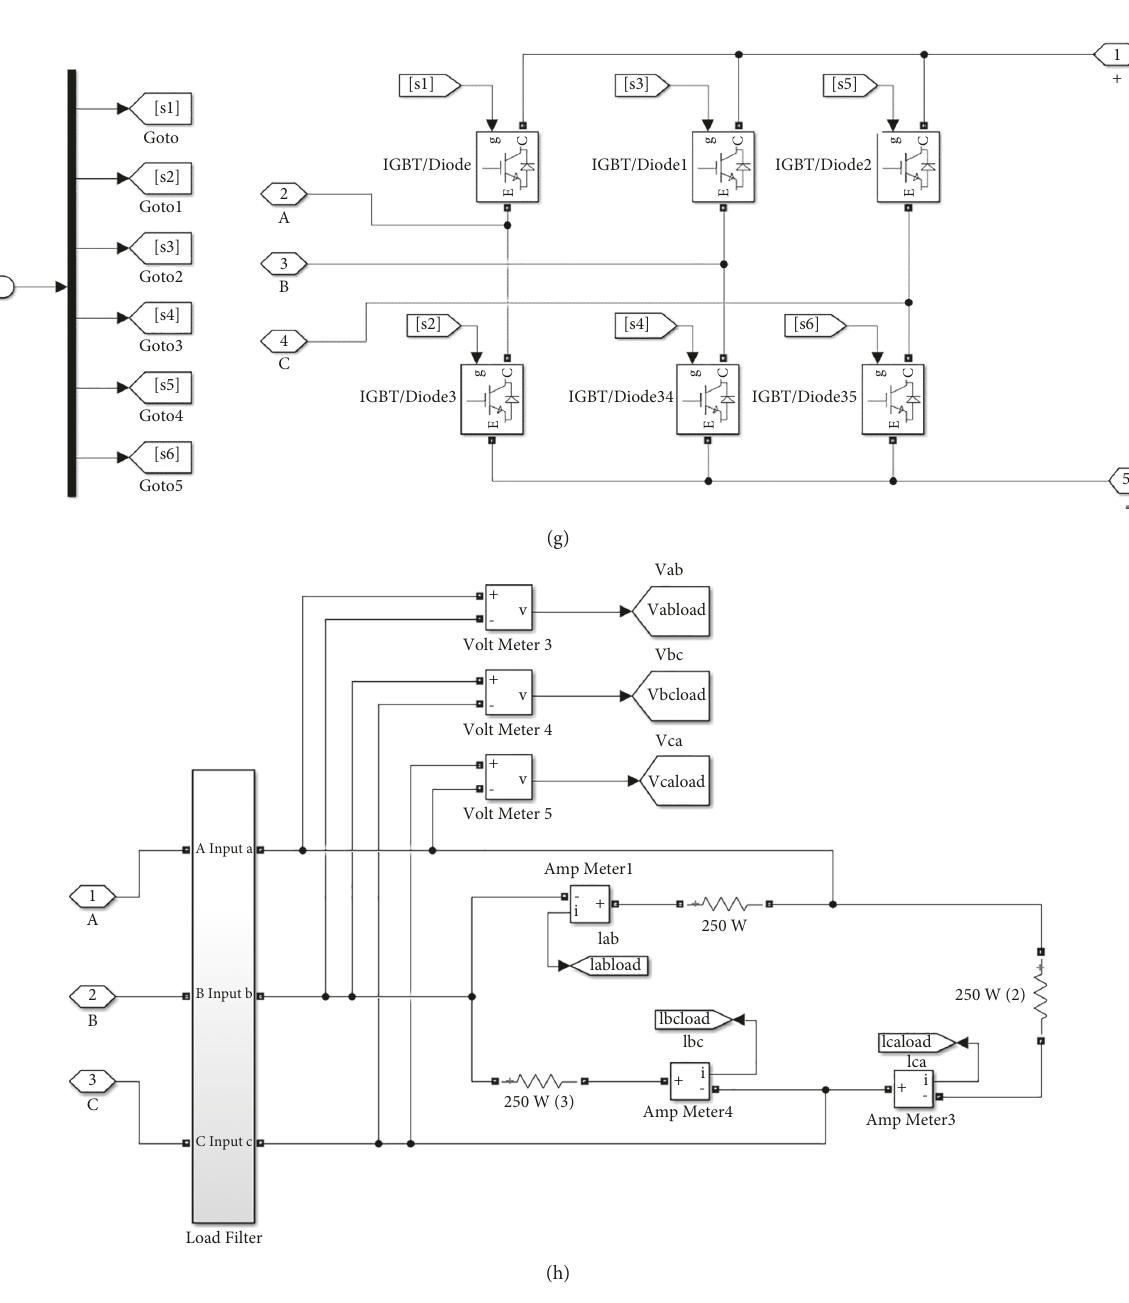
Figure 7: Model of the HVDC transmission line based on the experimental setup. (a) One-line diagram, (b) simulation model, (c) diagram and setup of the electric source block, (d) diagram and setup of the transformer block, (e) diagram and setup of the rectifier block, (f) diagram of the HVDC transmission line block, (g) diagram and setup of the inverter block, and (h) diagram and setup of the load block.